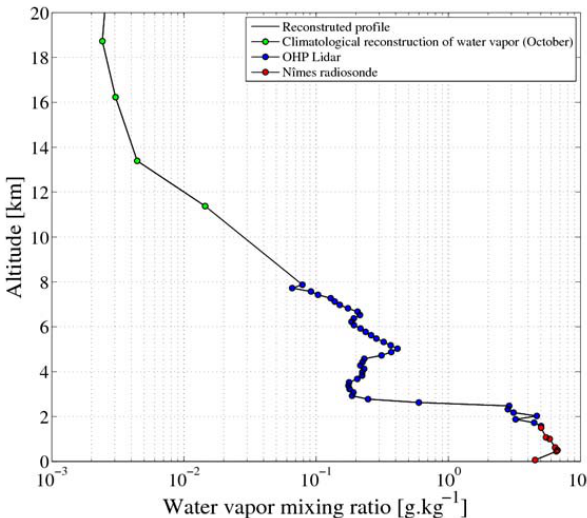
Fig. 3. The reconstruction of the total water vapour column of the NDACC OHP lidar measurements: using radiosonde data from op- erational radiosonde station at Nîmes at bottom of profile, lidar data in the middle, and a climatological model for the upper part. This is the standard calibration procedure used for the NDACC OHP